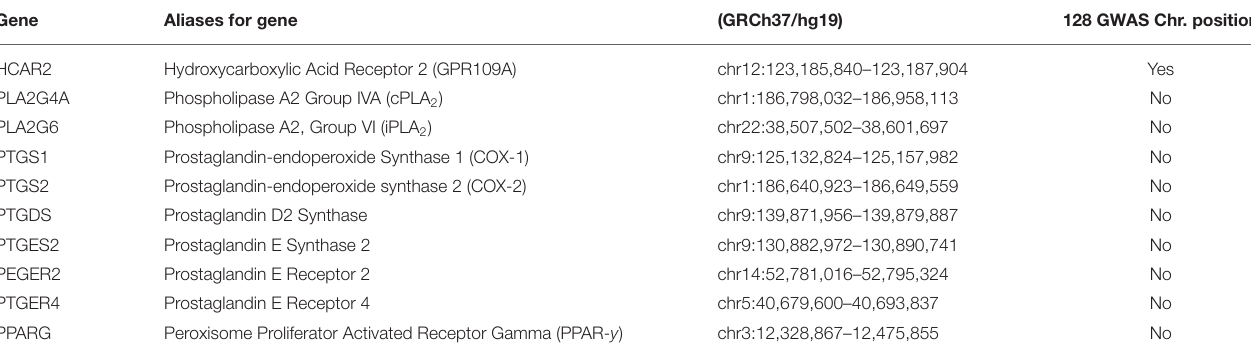
TABLE 1 | Genes in GPR109A-COX-prostaglandin pathways matched against 128 GWAS schizophrenia. Gene Aliases for